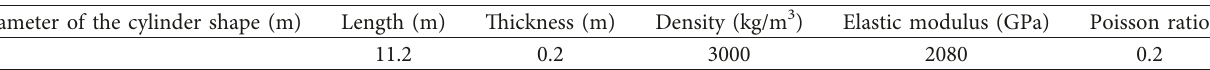
Table 2: Geometry and material parameters of shield machine.